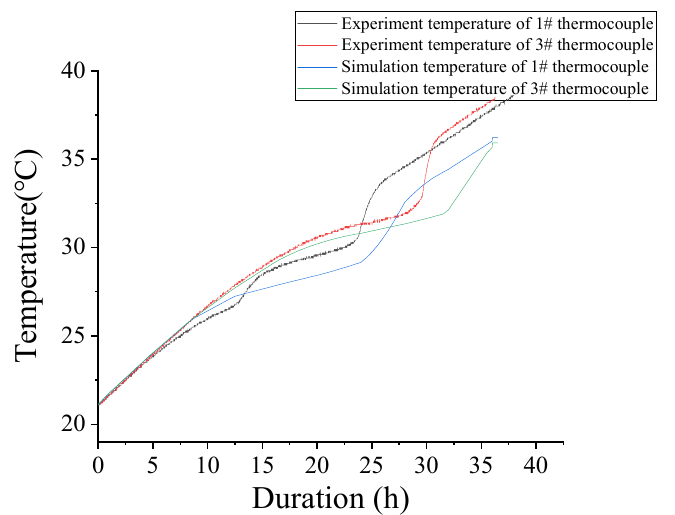
Figure 5. Comparison of the experimental and simulated values of temperature during phase change.